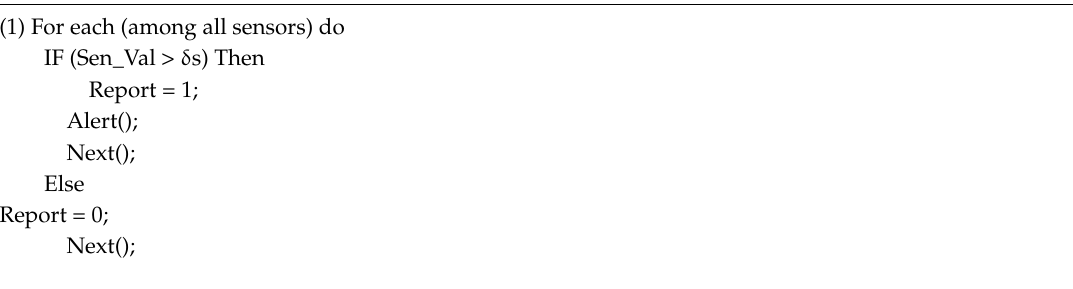
Algorithm 1: Proposed Work Algorithm